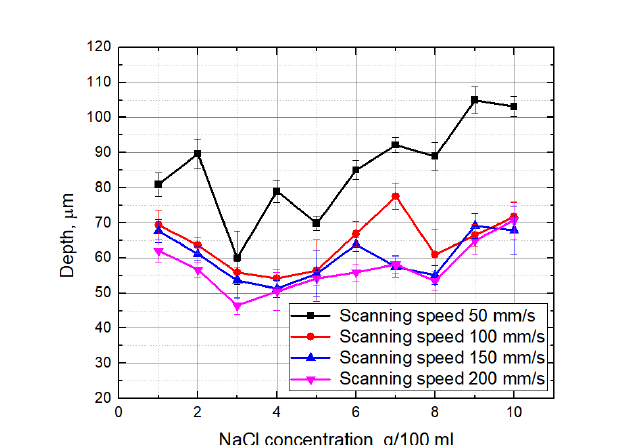
Figure 5. Depth of the grooves formed in the glass sample in dependence on the concentration of NaCl aqueous solution. Measurements were repeated at constant scan speeds: 50 mm/s, 100 mm/s, 150 mm/s, 200 mm/s. Number of scans—15, average power—5 W, pulse repetition rate—60 kHz. A similar experiment was performed with KOH aqueous solutions above the glass